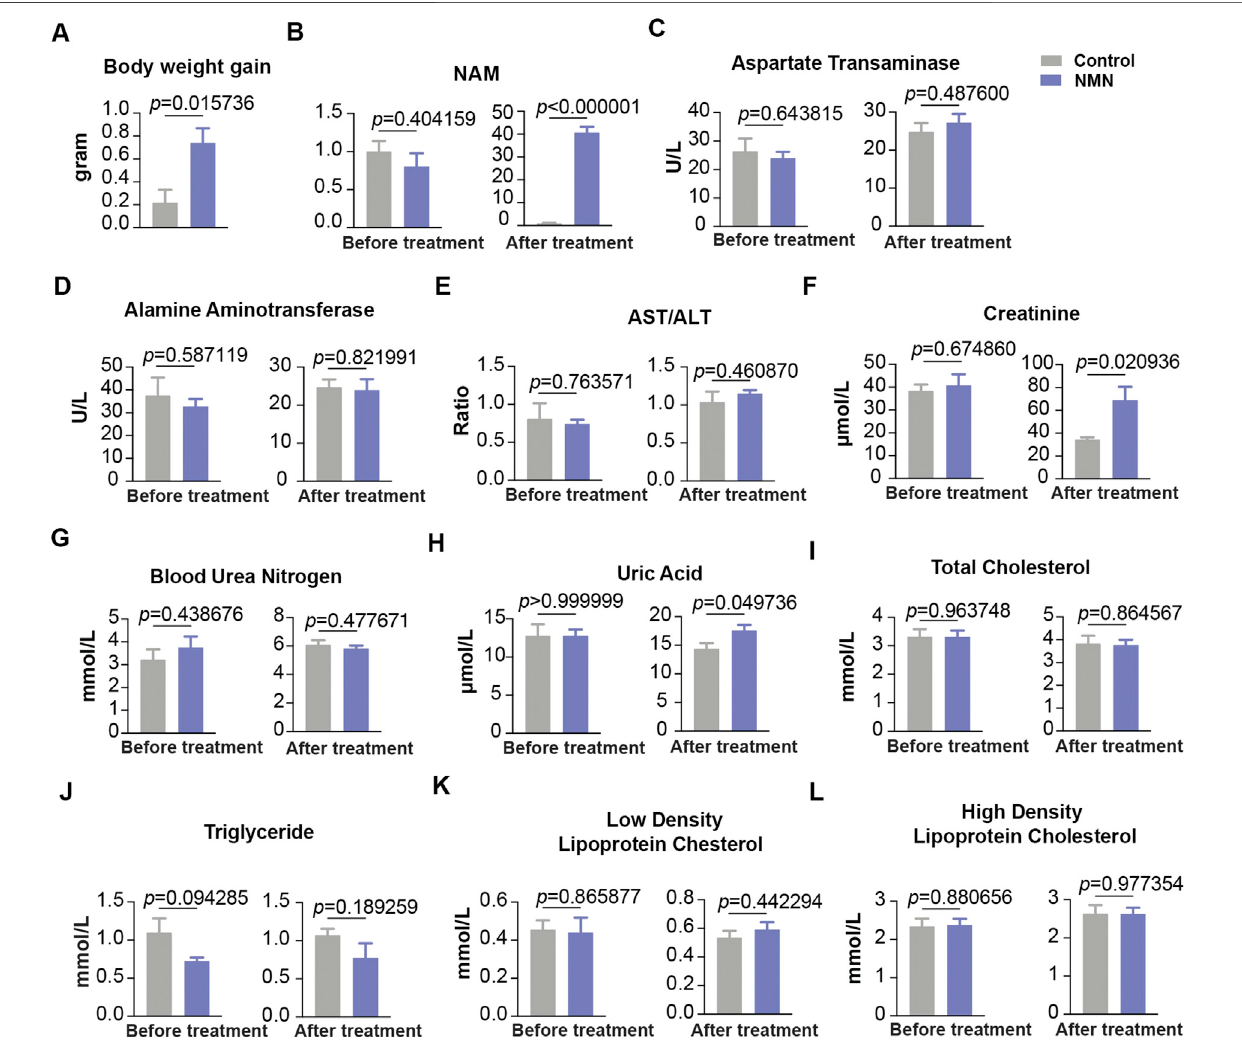
FIGURE 7 | The effect of oral 1340 mg/d NMN-administration on liver function, kidney function and blood lipids in beagle dogs (A) Body weights were measured before and after NMN administration. (B) Serum NAM levels were increased after NMN administration. (C – E) Liver function was analyzed after NMN administration. (F – H) Kidney function was analyzed after NMN administration. (F) Creatinine was evaluated in 1340 mg/kg/d NMN-administered dogs. (H) Uric acid was evaluated in 1340 mg/kg/d NMN-administered dogs. (I – L) Blood lipids were measured before and after NMN administration.